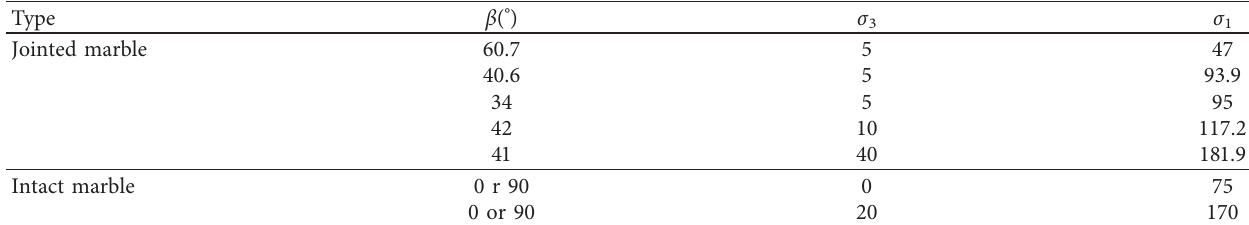
Table 6: Mechanical parameters of jointed marble and intact marble [65,